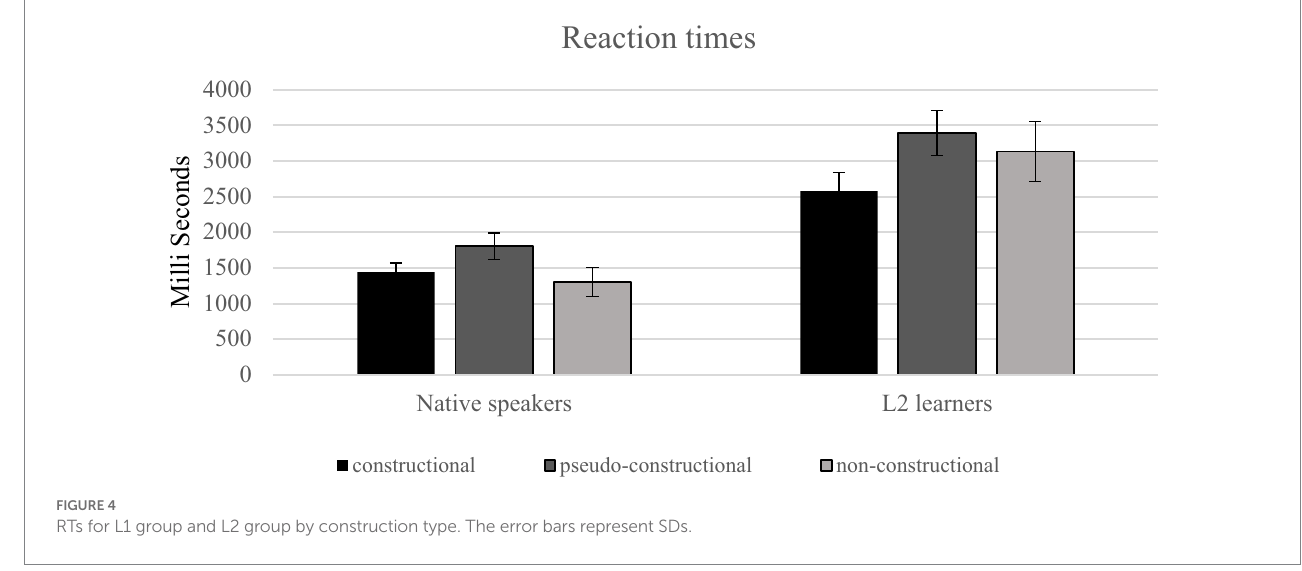
FIGURE 4 RTs for L1 group and L2 group by construction type. The error bars represent SDs.